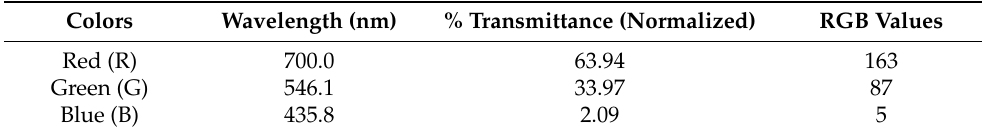
Table 1. Mapping of the transmittance to RGB